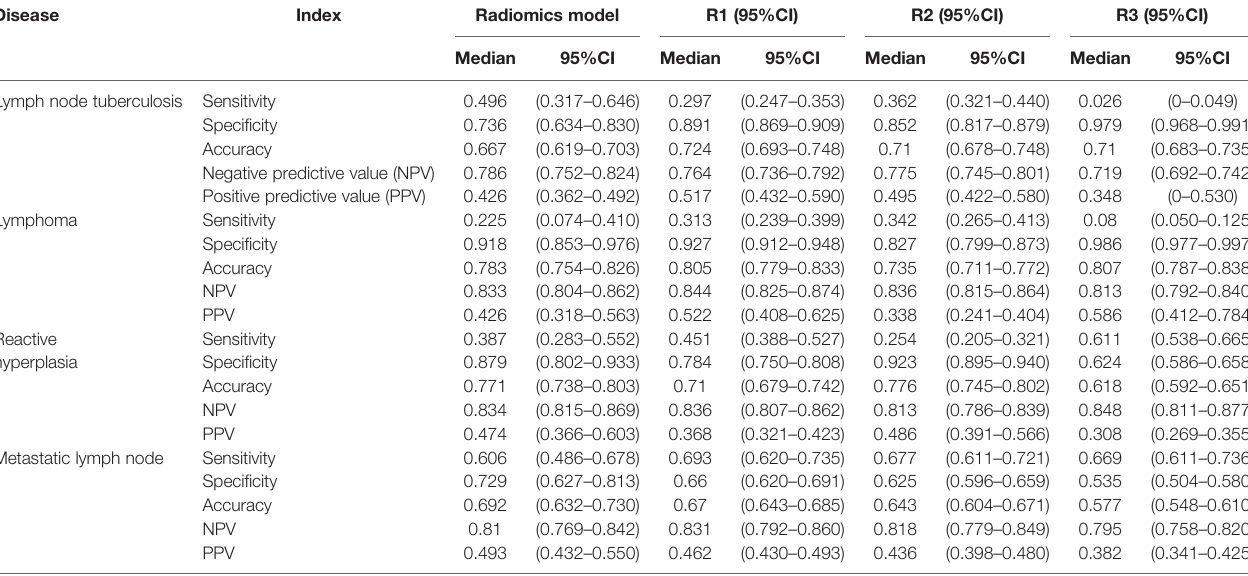
TABLE 3 | Comparison between radiomics model and senior radiologists in test set.